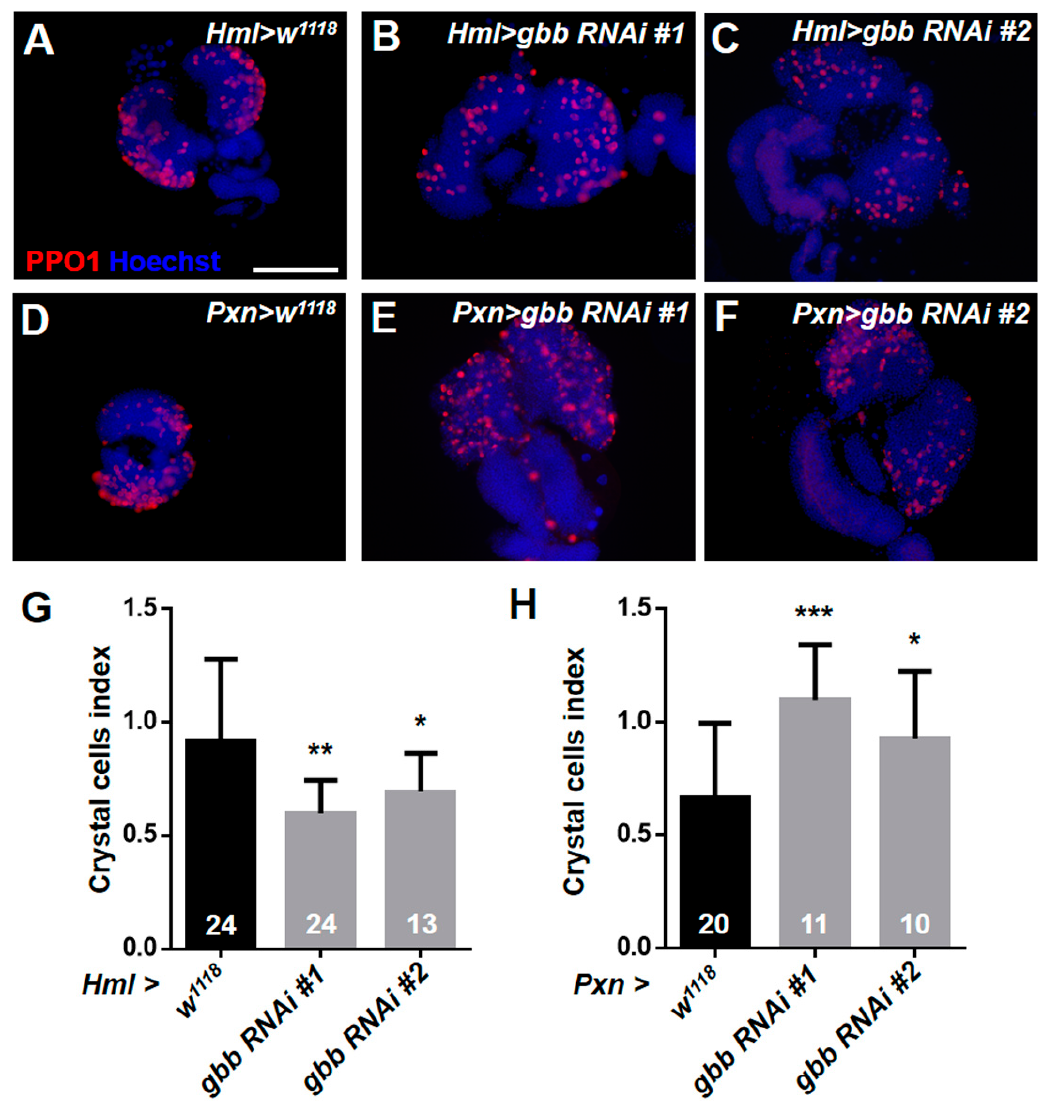
Figure 4. The knockdown of gbb in the CZ using the Pxn-Gal4 driver causes the excessive differenti- ation of crystal cells. ( A – F ) Immunostaining of the lymph gland with anti-PPO1 antibody showed that using Hml-Gal4 to knock down gbb reduced the differentiation of crystal cells ( A – C ), but using Pxn-Gal4 to knock down gbb induced the excessive differentiation of crystal cells ( D – F ). ( G , H ) Quan- tification of the number of crystal cells. For all quantifications: * p < 0.05; ** p < 0.01; *** p < 0.001 (Student’s t test). Scale bars: 100 µ m ( A – F